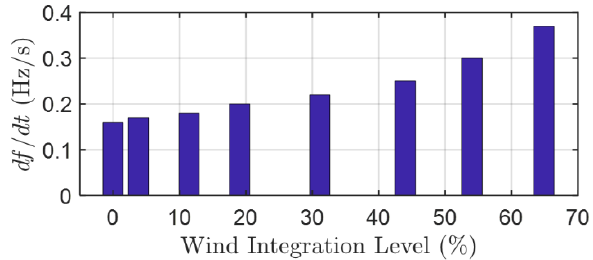
Figure 12. Rate-of-change-of-frequency (ROCOF) as a function of IBR integration